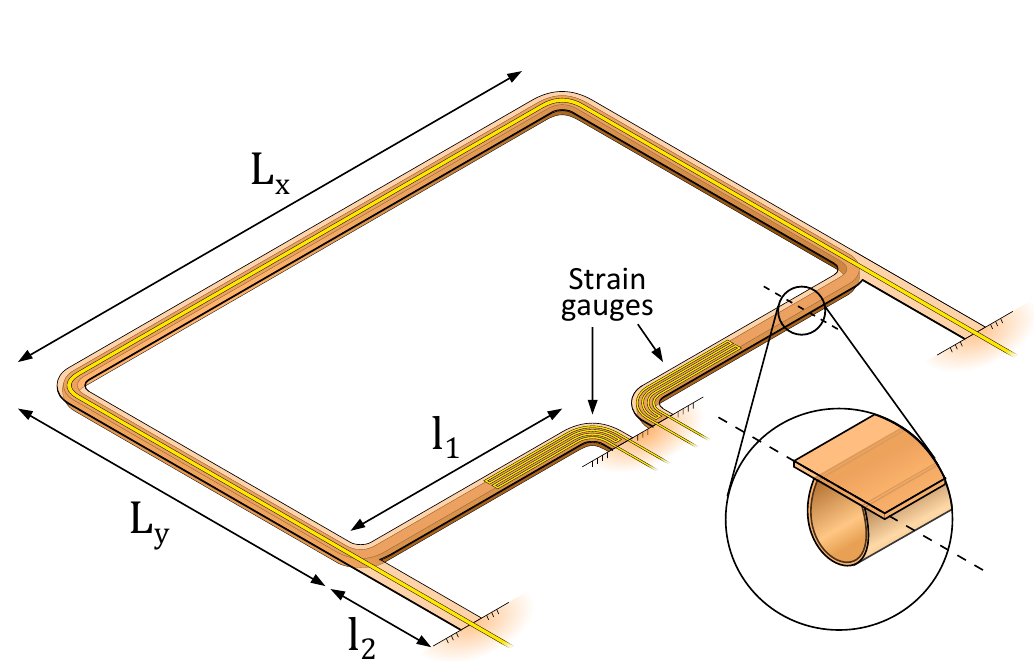
Figure 6. Design A/B: Two strain gauges are positioned on the in-/outlet channel sections. For design A, the strain gauge is designed to measure torsion of the channel section with length l 1 around its axis. For design B, the strain gauge is designed to measure bending of the same channel section along its axis. Two membranes with length l 2 connect the channel loop to the substrate to allow for the metal actuation track.